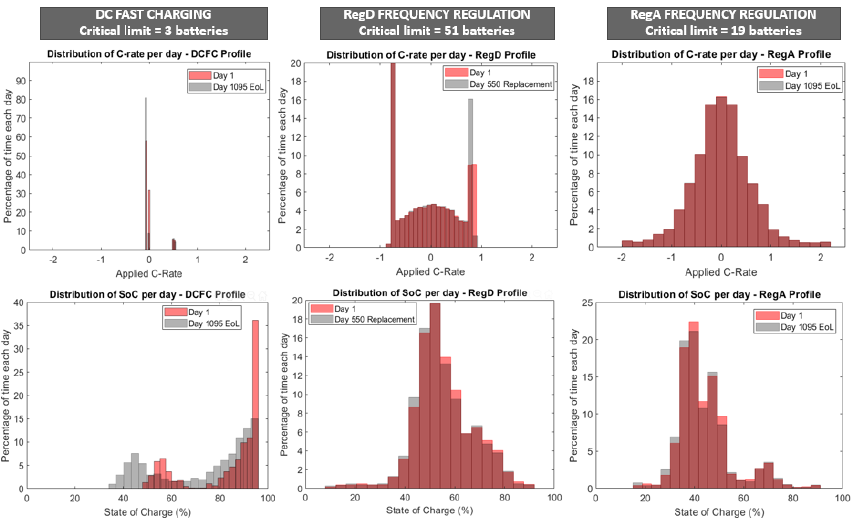
Figure 12. C-rate and SoC distributions on the pack level with power profile normalized by the critical number of batteries for each